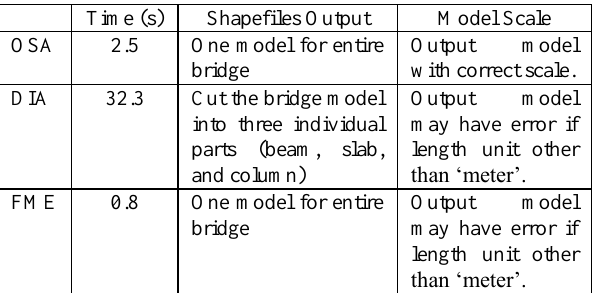
Table 1. Interpretation of data consistency.